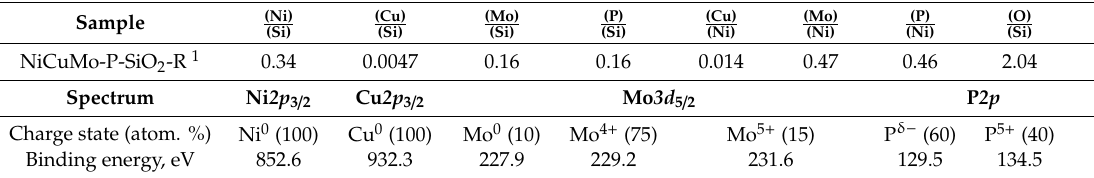
Table 5. Relative atomic concentrations of elements in the near-surface layer of NiCuMo-P-SiO 2 -R 1 catalyst (upper part of the table); Ni 2p 3 / 2 , Cu 2p 3 / 2 , Mo 3d 5 / 2 , and P 2p binding energies and charge states of elements with distribution in atomic % (lower part of the